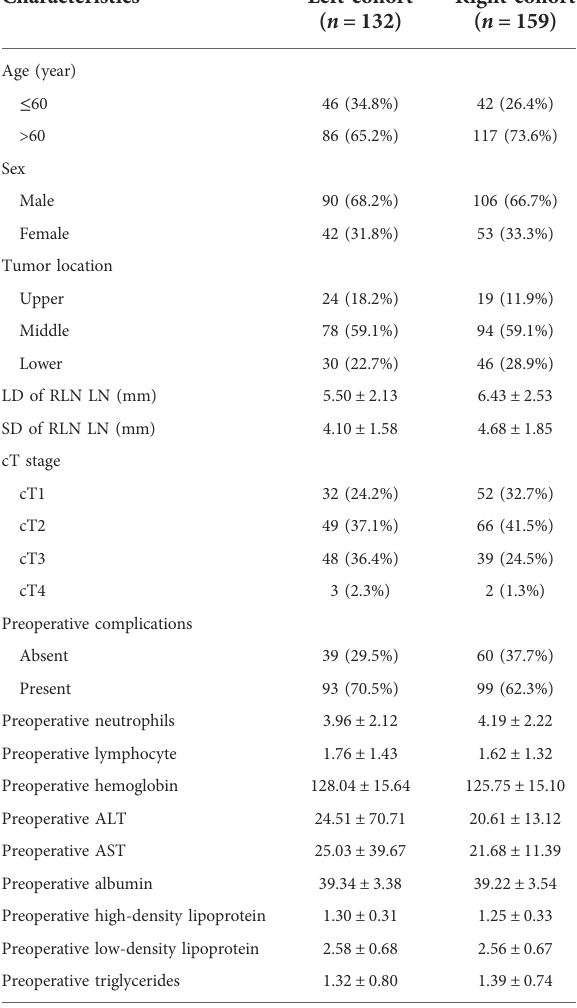
TABLE 1 Summary of clinical characteristics in the study population.